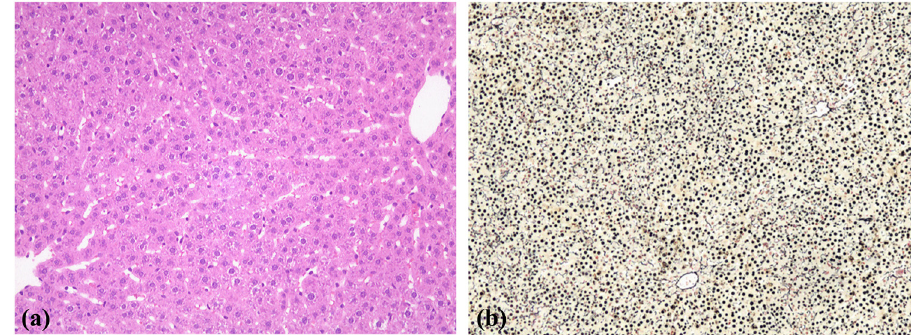
Figure A3: Liver pathology of the control group. The structure of the liver tissue was normal, with no fi brous tissue hyperplasia (( a ) HE100 × , ( b ) Reticulum Masson40 ×)